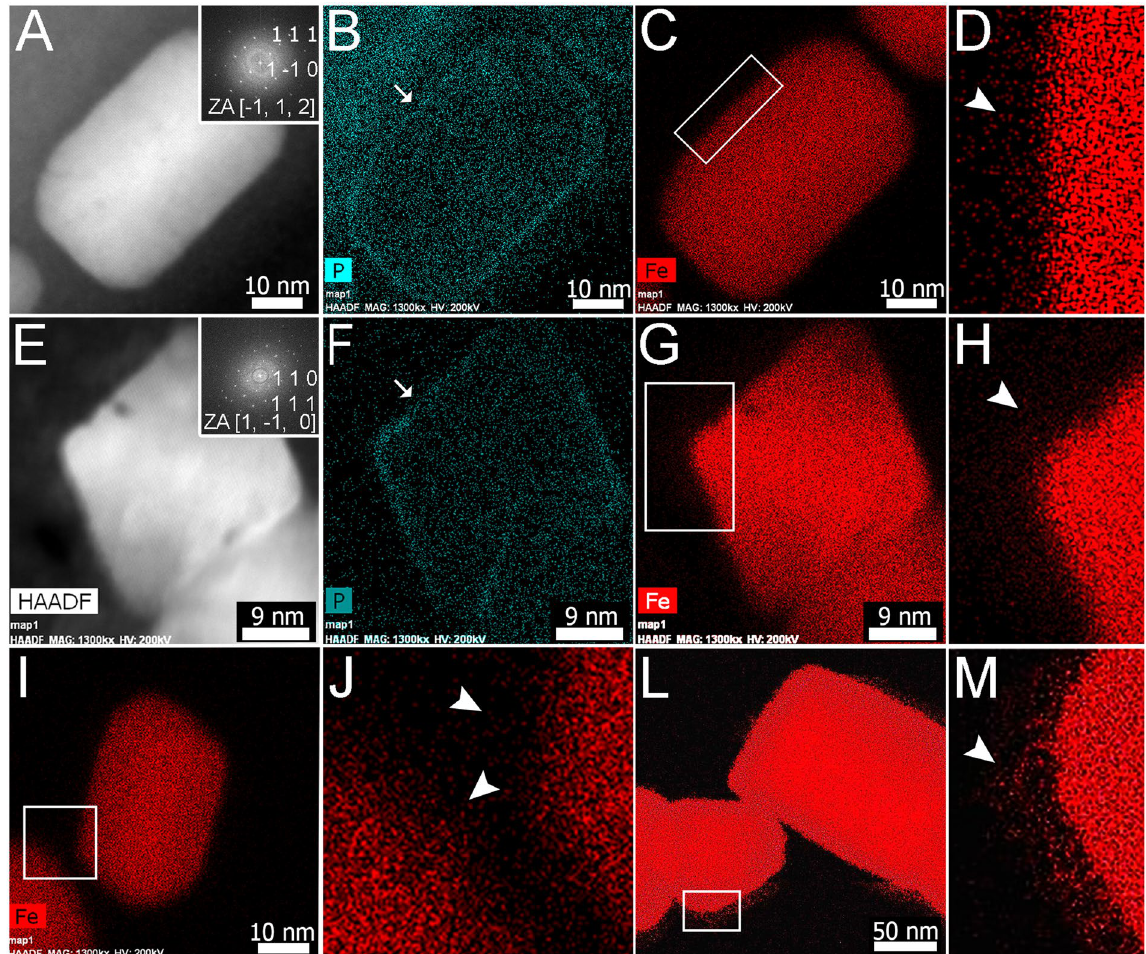
Figure 5. High resolution STEM imaging and EDS elemental maps of cells of cultured: Magnetovibrio blakemorei strain MV-1 cell ( A – D and I,J ), Magnetofaba australis strain IT-1 ( E – H ) and from uncultured coccoid MTB from the Mediterranean Sea ( L , M ). ( A ) STEM-HAADF image showing a prismatic Fe 3 O 4 magnetosome observed edge-on. Inset shows fast Fourier transform (FFT) analysis of Fe 3 O 4 with indexation. ( B ) P map of the region shown in ( A ). Arrow denotes the magnetosome membrane evidenced by the higher intensity of P due to the presence of phospholipids. ( C ) Fe map of the region shown in ( A ). ( D ) High magnification Fe map of the region shown in ( C ) showing the presence of Fe surrounding the magnetosome (at arrow). ( E–H ) same as ( A ) to ( D ) but for Mf. australis strain IT-1. ( I ) Fe map of Fe 3 O 4 magnetosome from Mv. blakemorei . ( J ) Enlarged Fe map of the intermagnetosome region of cell of Mv. blakemorei inside ( I ). Note the diffuse Fe distribution surrounding magnetosomes (arrowheads). ( L ) Fe map of Fe 3 O 4 magnetosome from a cell of the uncultured magnetotactic coccus from the Mediterranean Sea. ( M ) High magnification image of a region of the Fe map inside the rectangle in ( L ) showing Fe surrounding the magnetosome (arrowhead).